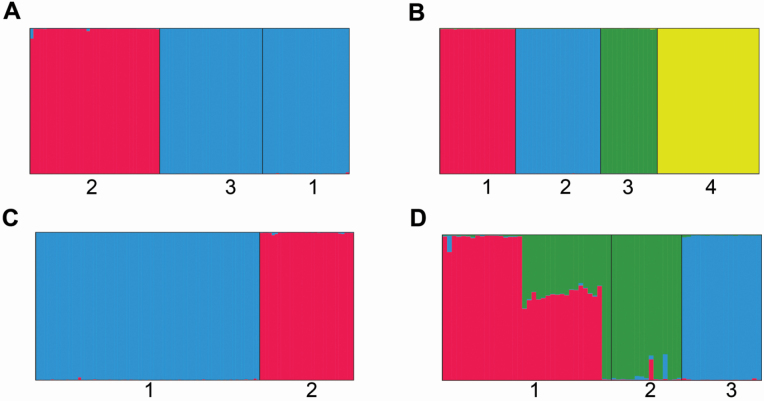
Metapopulations’ genetic group structure analysis by InStruct for Zingiber corallinum (A—GDZJ, K = 2; B—GDYX, K = 4) and STRUCTURE for Z. nudicarpum (C—HNCJ, K = 2; D—HNBT, K = 3). Each individual vertical bar represents an individual and the black vertical bars separate the subpopulations, while different colours represent different gene pools.